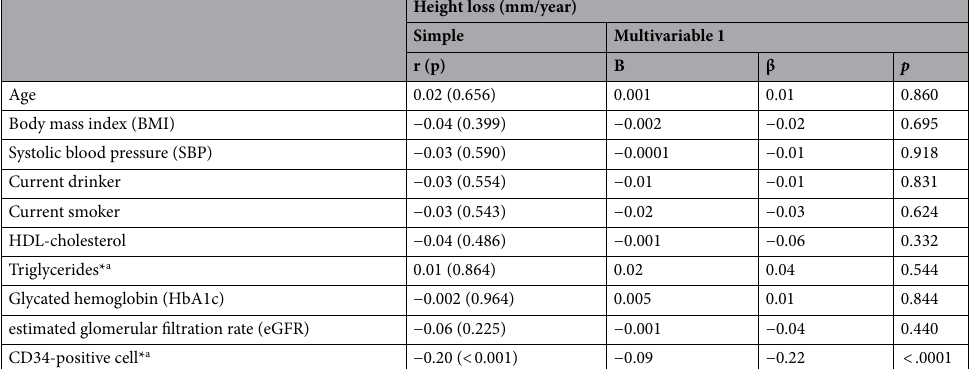
Table 3. Correlation between height loss as a continuous variable and circulating CD34-positive cell count adjusted for cardiovascular risk factors. r: simple correlation coefficient. Β: parameter estimate. β: standardized parameter estimate. Multivariable 1, adjusted further for age plus body mass index (BMI), systolic blood pressure (SBP), current-drinker, current-smoker, HDL-cholesterol, triglycerides, glycated hemoglobin (HbA1c), and estimated glomerular filtration rate (eGFR). *a: Logarithmic transformation were performed.